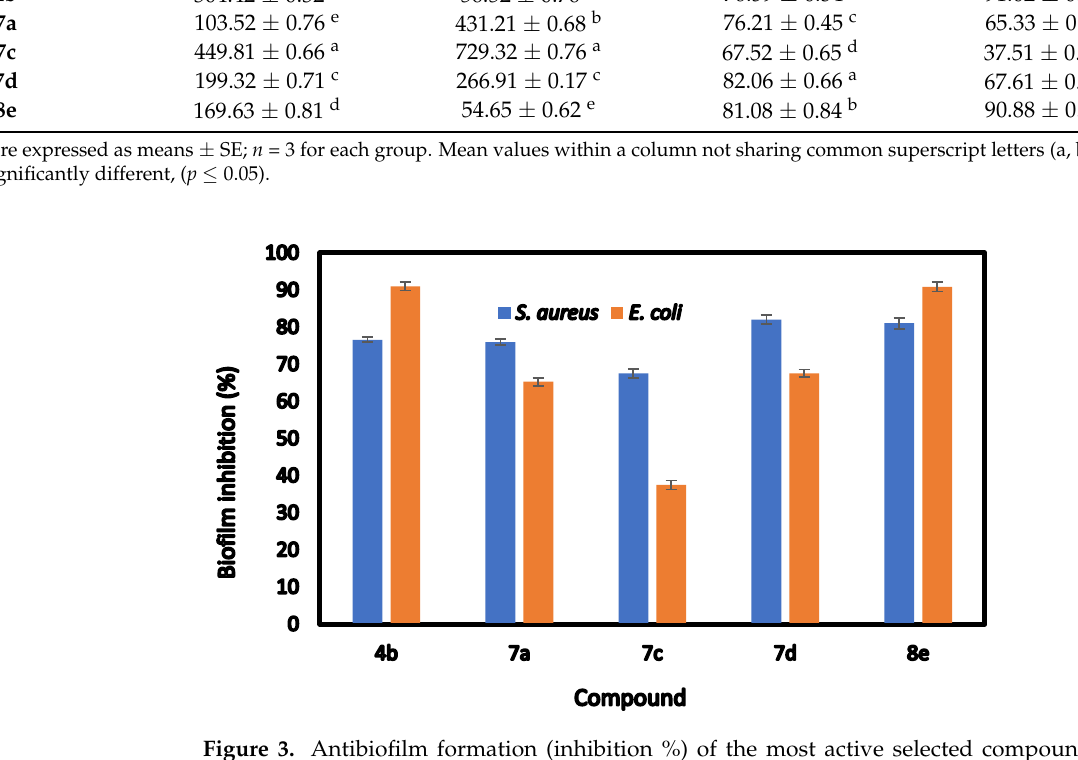
Figure 3. Antibiofilm formation (inhibition %) of the most active selected compounds against Staphylococcus aureus (blue), and Escherichia coli (orange). Values are expressed as means ± SE; n = 3 for each group.